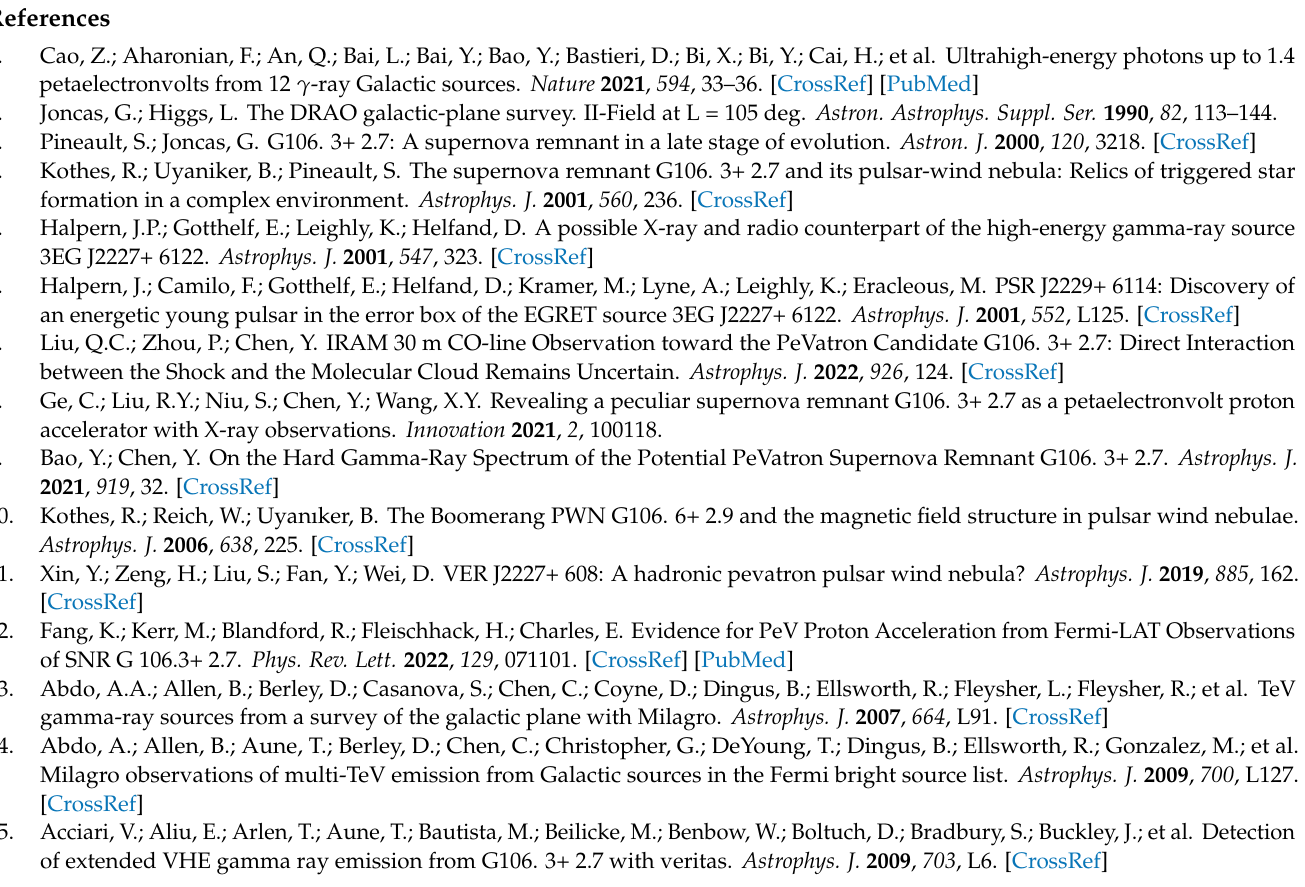
Figure A1. Comparison between functions from both sides of Equation (A1). The upper panel shows the two functions over five orders of magnitude, with the orange dashed line denoting the left side of Equation (A1) and the blue solid line denoting the right side of Equation (A1) from Jüttner distribution. The lower panel shows the ratio of the value of the original function to the approximate value of the substitute in the black dashed line, with the red solid line being unity for